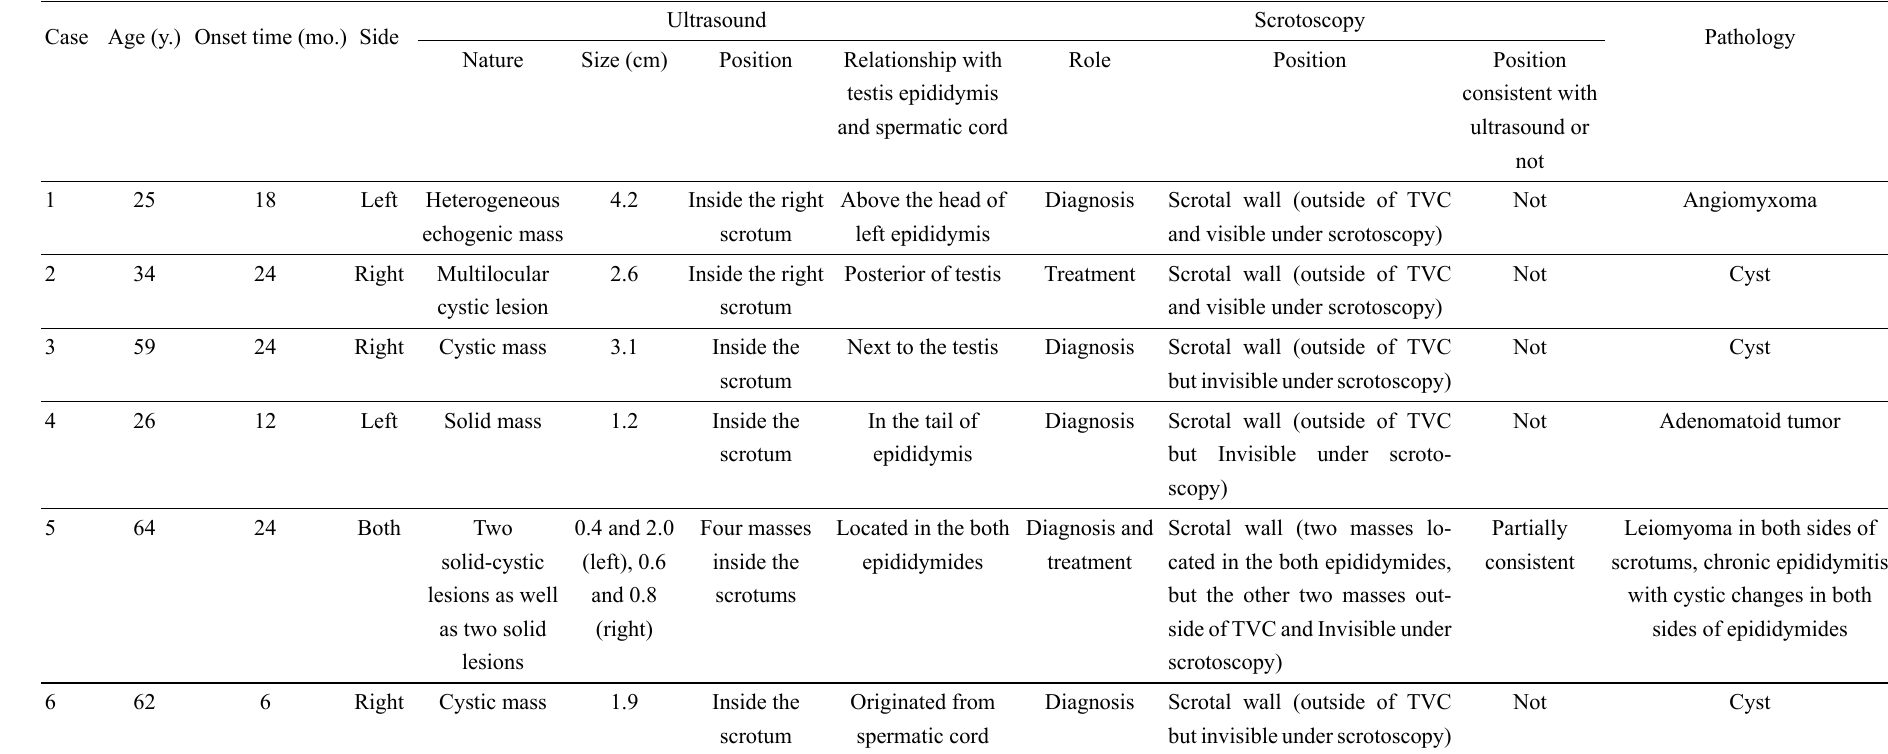
Table 1. Comparison of ultrasound and scrotoscopic results for scrotal wall